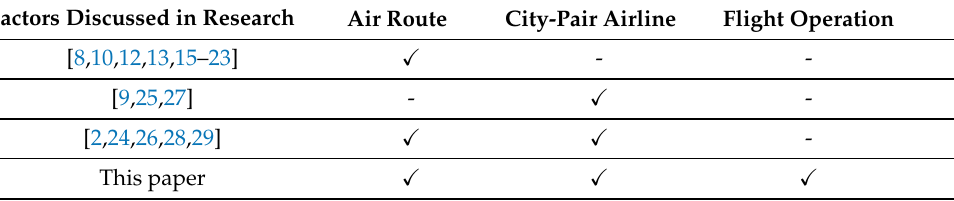
Table 1. Three different factors of air transportation network and most researches hardly cover flight operation